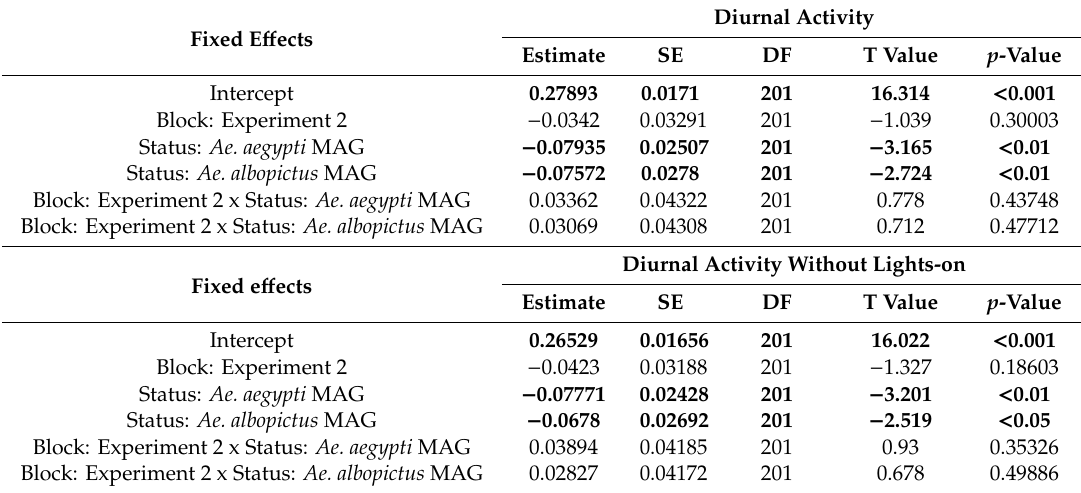
Table 2. Estimated fixed e ff ects of status, block, and status x block interaction in Ae. albopictus females. Bold entries indicate statistically significant results ( p <